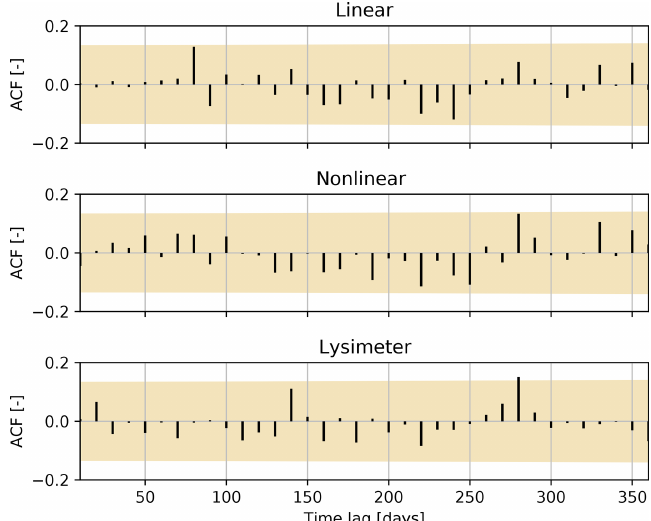
Figure A1. Autocorrelation graphs for all three models for lags of up to 1 year. The shaded area shows the 99% confidence interval for the autocorrelation function (ACF).